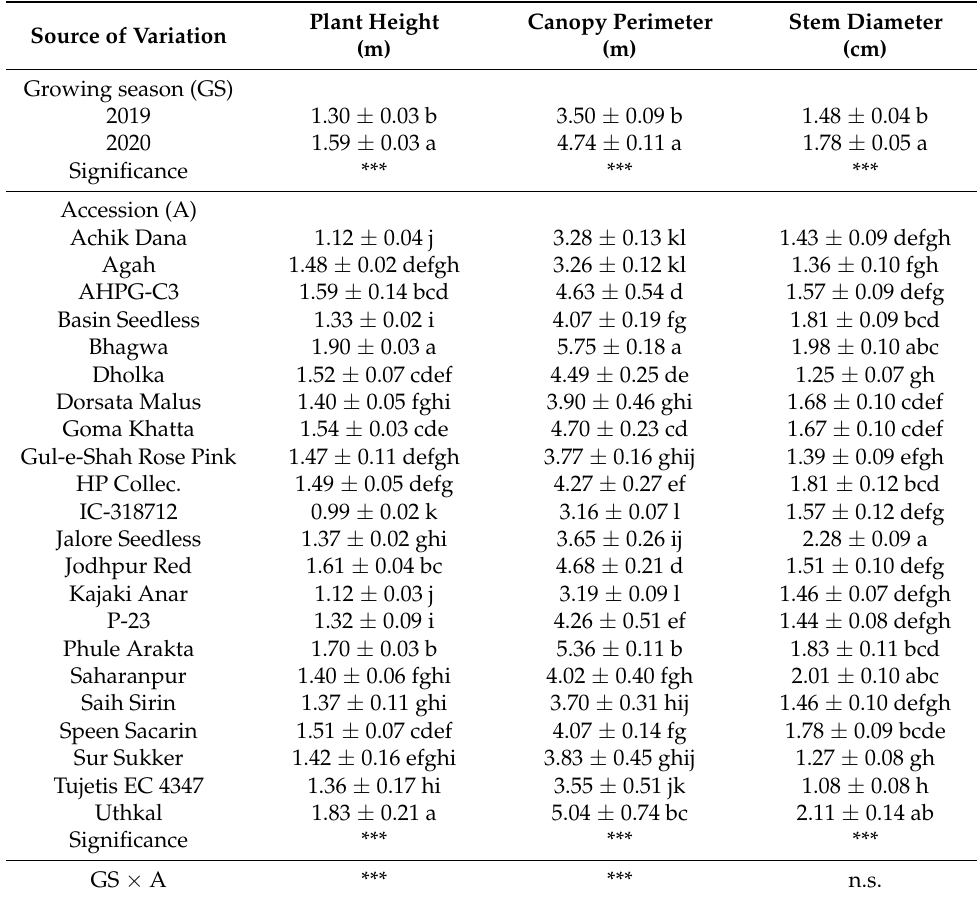
Table 2. Effect of the growing season, accession, and their interaction on vegetative traits of pomegranate plants. Separately for each source of variation and within each column, means followed by a common letter are not significantly different according to the Tukey test ( p ≤